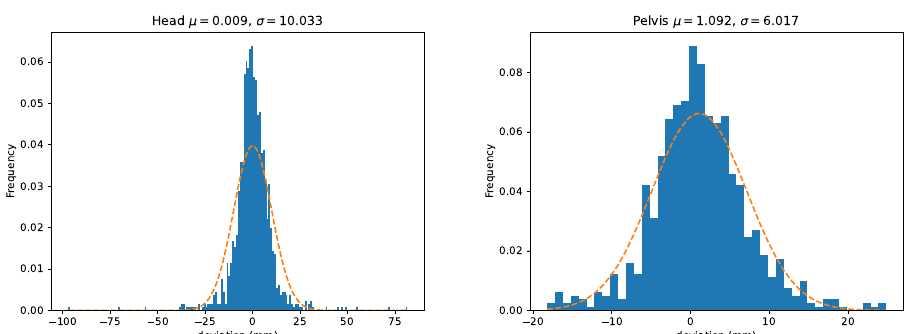
Figure 7. Distributions of the per-stride deviations for head ( left ) and pelvis ( right ). Here we have combined both peak and valley deviations defined in Section 2.7.1 ( ∆ V and ∆ P ). The dashed line displays the normal distribution estimated from the means and standard deviations of the between-systems deviations.